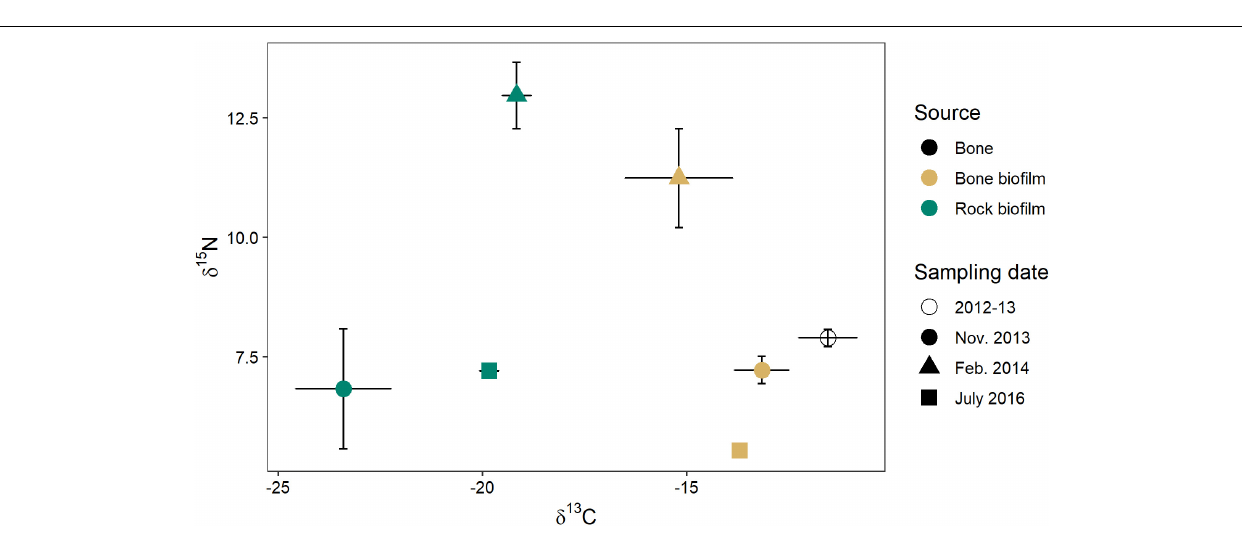
Frontiers in Ecology and Evolution |